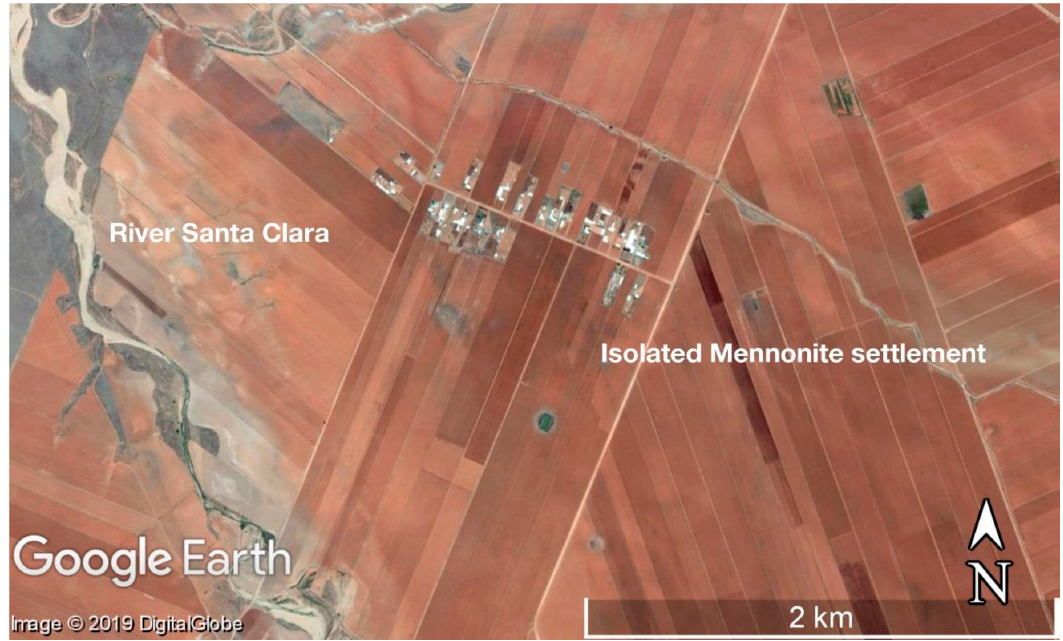
Figure 2. Mennonite settlement “Field 92” next to the River Santa Clara, that later becomes the River Carmen. Image obtained from Google [51].